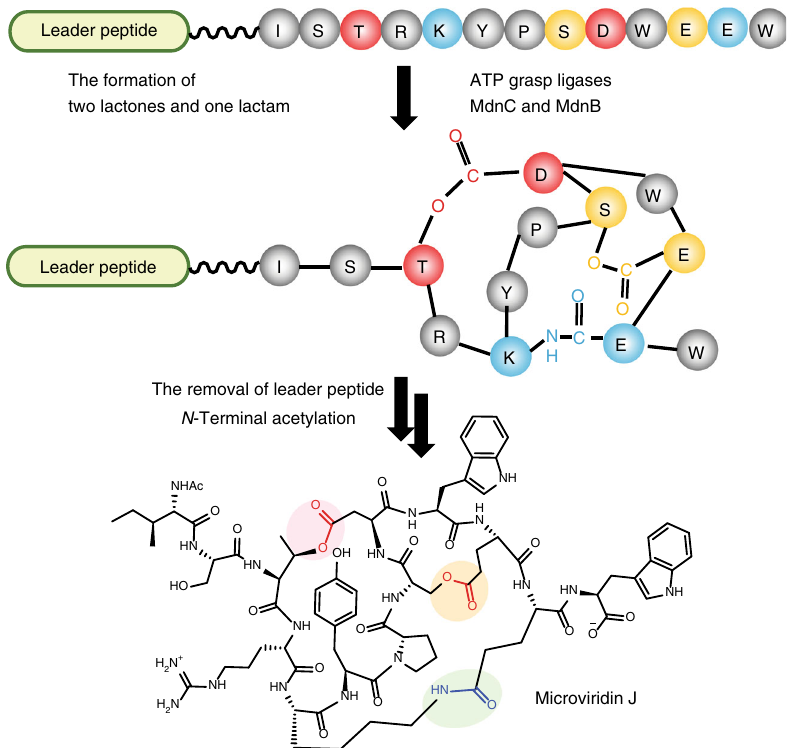
Fig. 1 Schematic representation of microviridin J biosynthesis. MdnC installs two macrolactones on MdnA, followed by the macrolactamization by MdnB. The modi fi ed core is then released for an N -acetylation modi fi